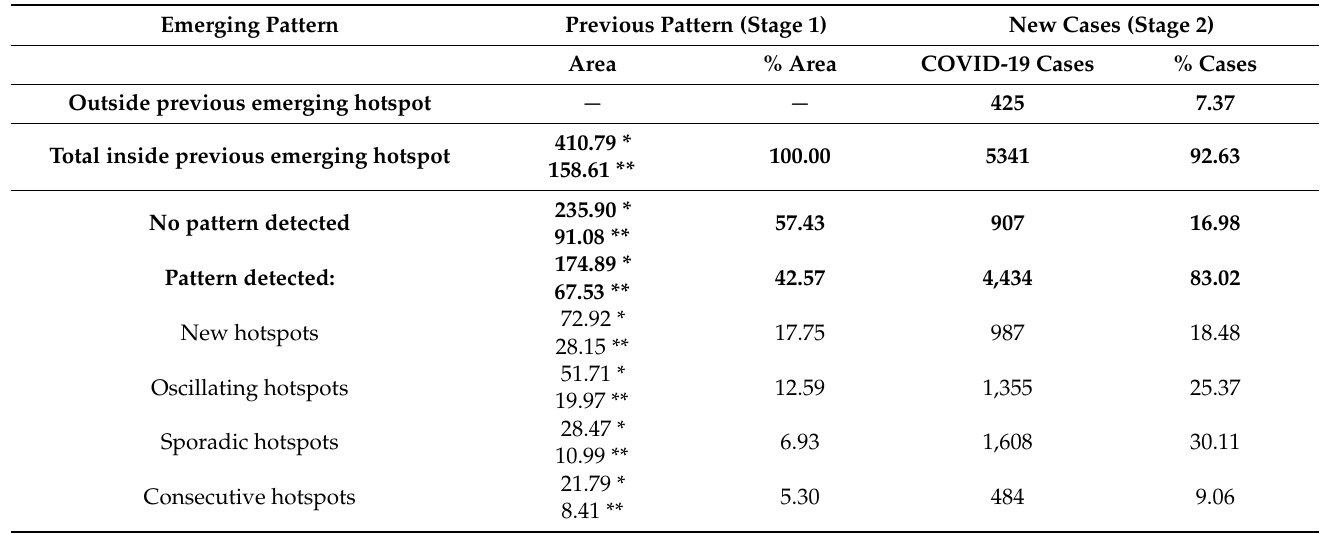
Table 4. Location of new COVID-19 cases in relation to the emerging hotspot model from stage